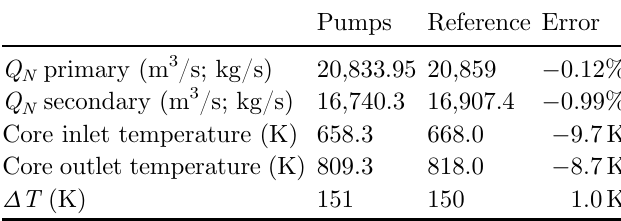
Table 6. Steady-state results (3D). Pumps Reference Error Fig. 6. Coolant mass